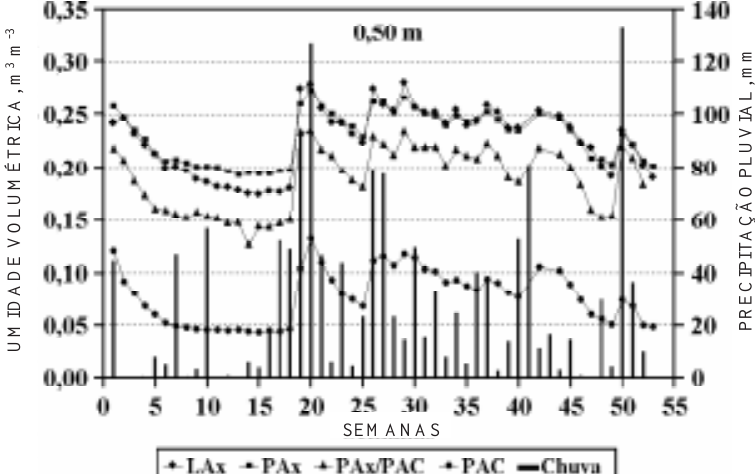
Figura 4. Variação da umidade nos solos Latossolo Amarelo argissólico (LAx), Argissolo Amarelo (PAx), solo transicional PAx/PAC e Argissolo Acinzentado (PAC), nas 53 semanas de avaliação, na profundidade de 0,50 m, e precipitação pluvial no período, em uma toposseqüência em tabuleiro do estado da